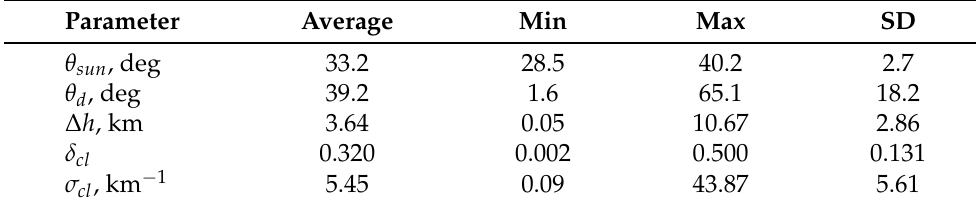
Table 1. Initial values of the parameters θ sun , θ d , ∆ h , δ cl , and σ cl for the considered images. Parameter